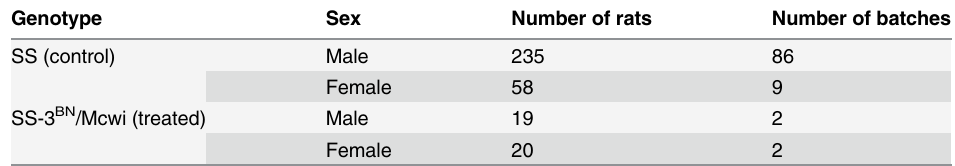
Table 1. Rat dataset characteristics for the peak contracture pressure variable of the cardiac study comparing SS and SS-3 BN /Mcwi strains. Genotype